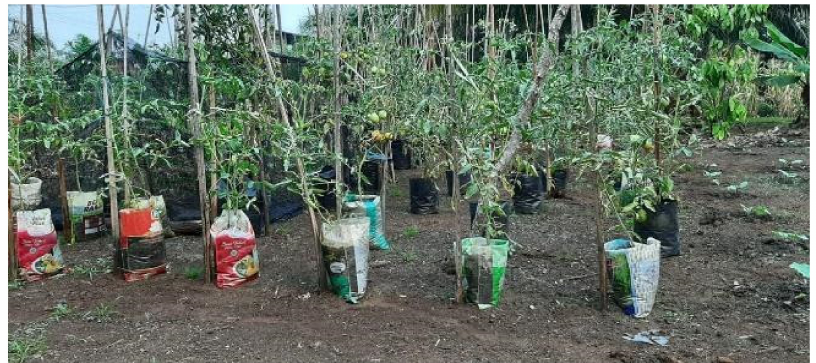
Figure 6. Planting agricultural crops in